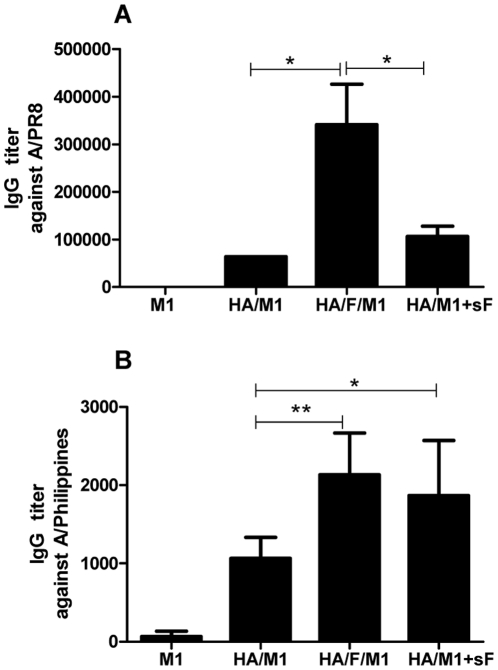
Serum IgG endpoint titers.Endpoint titers of immune serum IgG specific to A/PR8 (A) or cross-reactive binding to A/Philippines (B) were determined using ELISA as described in Materials and Methods. HRP-conjugated goat anti-mouse IgG antibody was used for detection. Endpoint titers were defined as in Fig 1. M1, M1 only VLPs; HA/M1, HA/M1 VLPs; HA/F/M1, HA/flagellin (FliC, F)/M1 cVLPs; HA/M1+sF, mixture of HA/M1 VLPs plus soluble flagellin (sFliC, sF).